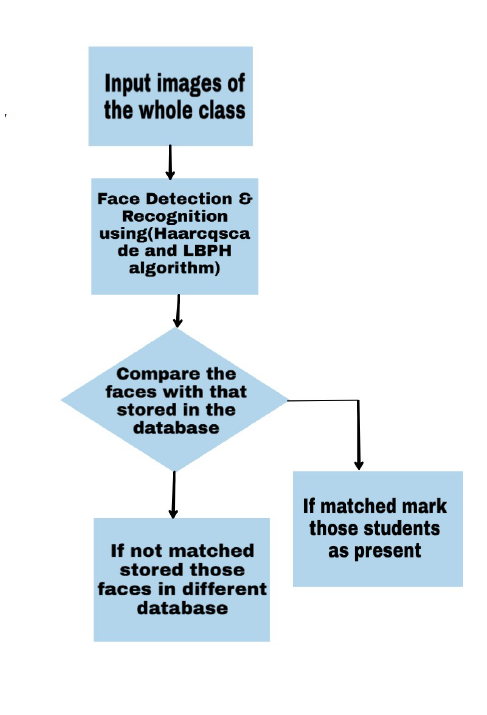
Figure 6. Image matching and verification.